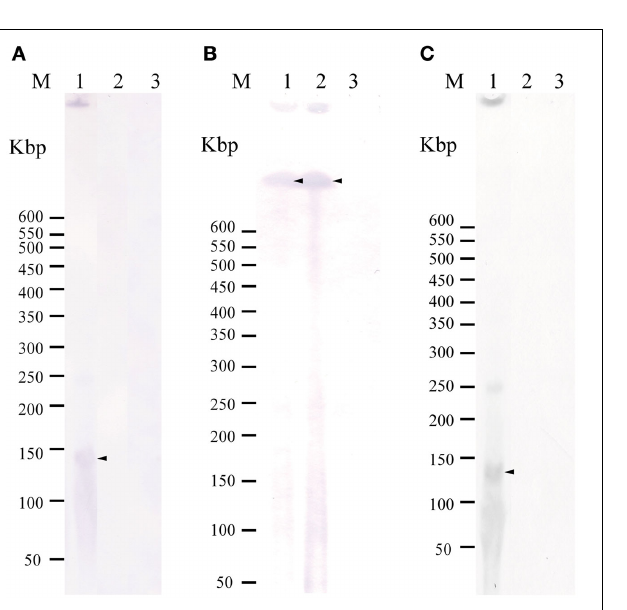
04Ya001; 2, 04Ya016; 3, 04Ya090; 4, 04Ya108; 5, 04Ya265; 6, 04Ya311; 7, TJ001W1; 8, TJ016W1; 9, TJ090W1; 10, TJ108W1; 11, TJ265W1; 12, TJ311W2 and 13, W3110. Approximately, 20ng of DNA was loaded in each lane. Arrows indicate the positions of the bands.